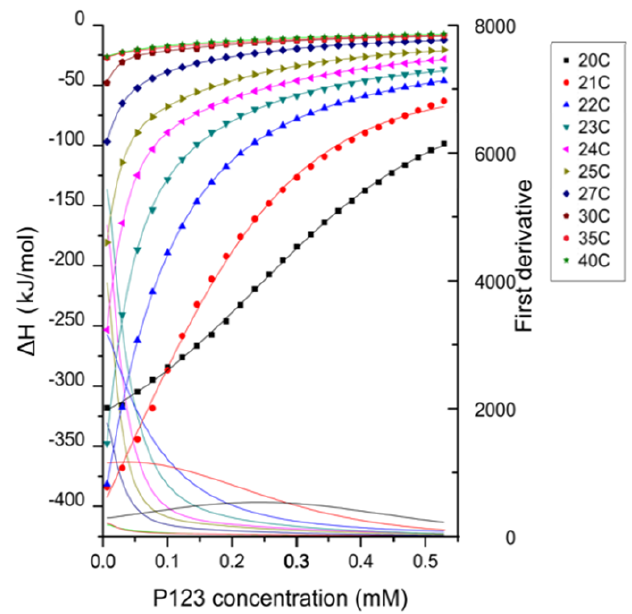
Figure 2. Enthalpy changes generated by titrating 3.2 mM Pluronic P123 in water at varied temperatures (shown in the legend) in the range 20 to 40 °C. The titrant concentration is well above the critical micelle concentration (CMC) (0.313 mM at 20 °C [13]). The enthalpy change for each injection was obtained by ITC and then was standardized by dividing by the amount of the injected Pluronic for each injection. The maximum of the first derivative of the enthalpogram (solid lines) indicates the CMC.